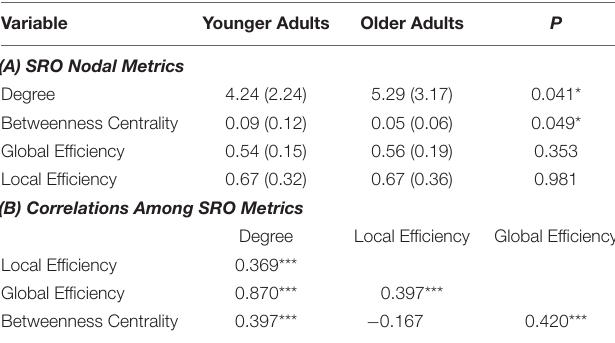
TABLE 4 | Metrics calculated in association with the “serial recall order” node (A) and metric-to-metric